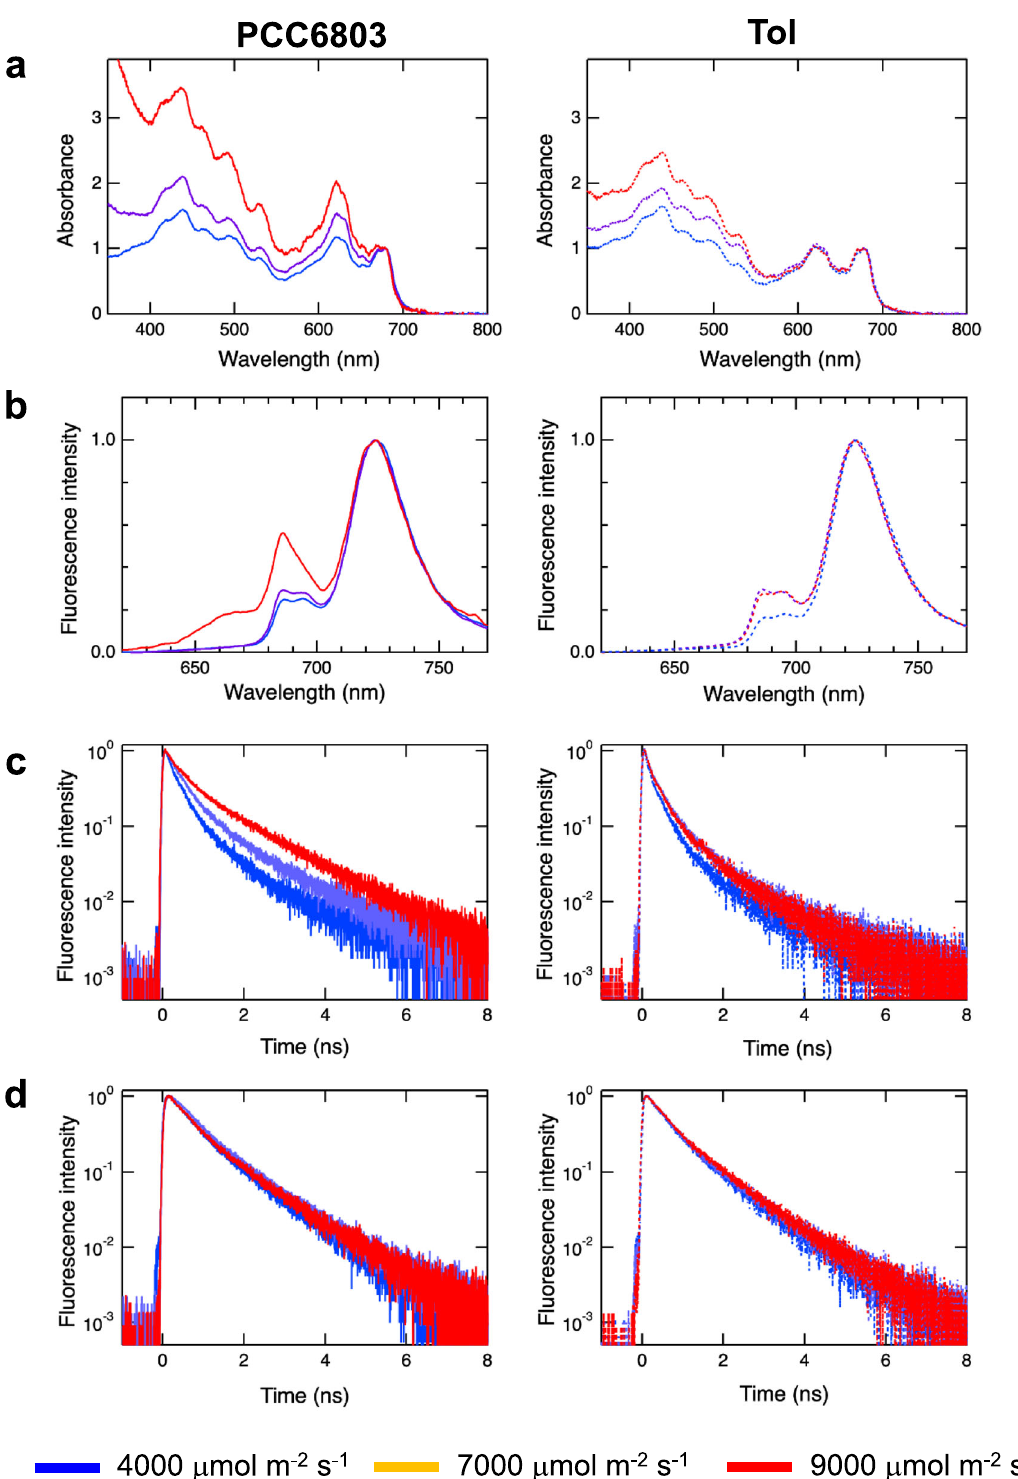
Fig. 4 Characterization of photosynthetic abilities in PCC6803 and Tol strains. a Absorption spectra normalized at the chlorophyll Qy band. b Fluorescence spectra normalized at the PSI band (<725 nm). c Fluorescence decay curves of PSII normalized to maximum intensities. d Fluorescence decay curves of PSI normalized to the maximum intensities. Graphs to the left and right represent PCC6803 and Tol strains, respectively. Blue, purple, and red lines represent 4000, 7000, and 9000 μ mol m − 2 s − 1 , respectively. The absorption spectra, fl uorescence spectra, and fl uorescence decay curves were measured at 48 h for all